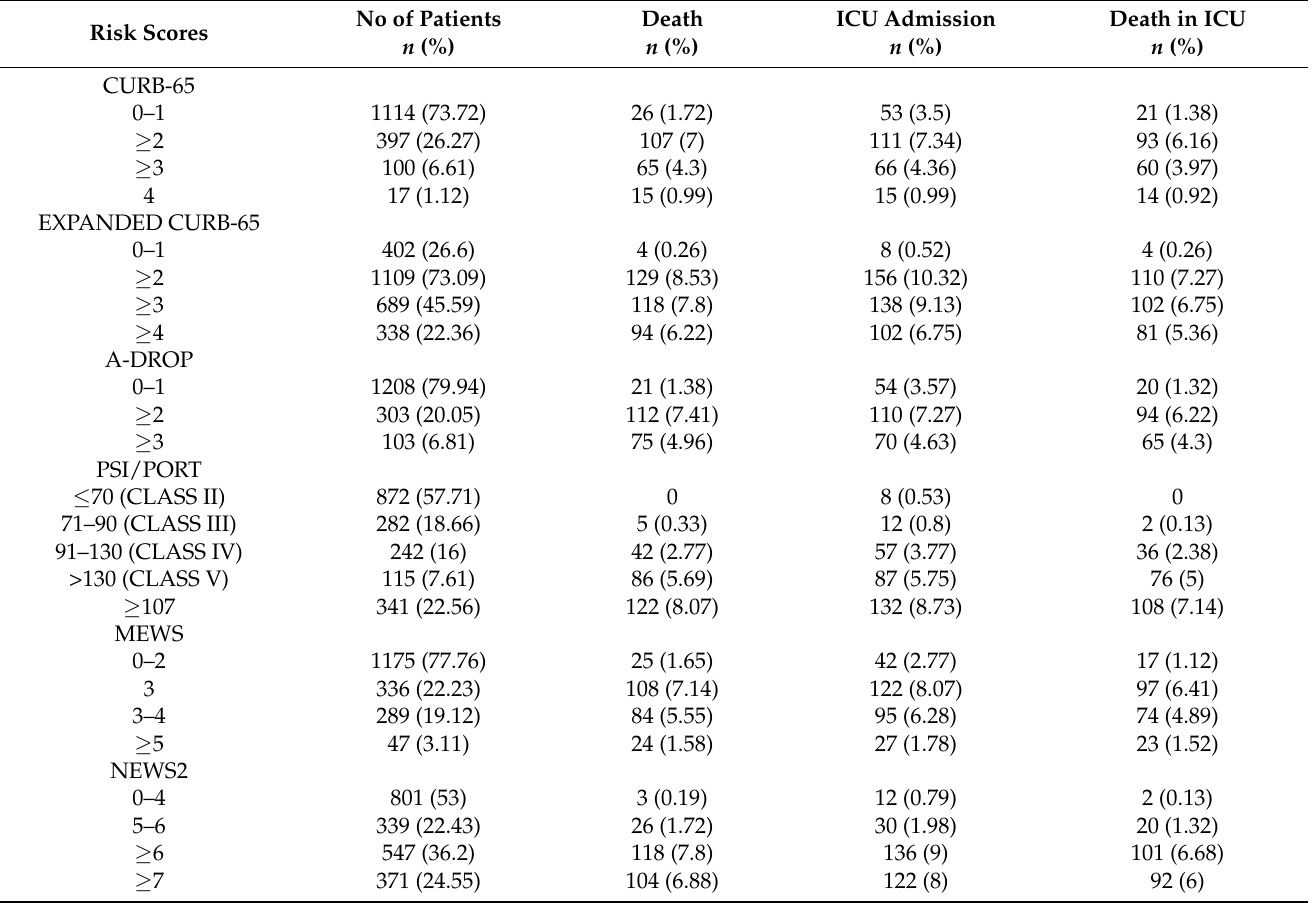
Table 4. The rates of in-hospital fatality and ICU admission across risk groups based on